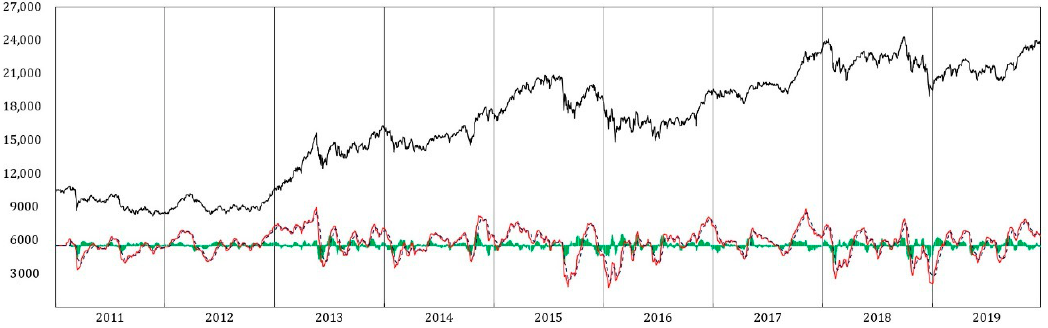
Figure 1. Index Value of Nikkei 225 Futures and moving average convergence (MACD) (12,26,9) over the past 9 years.